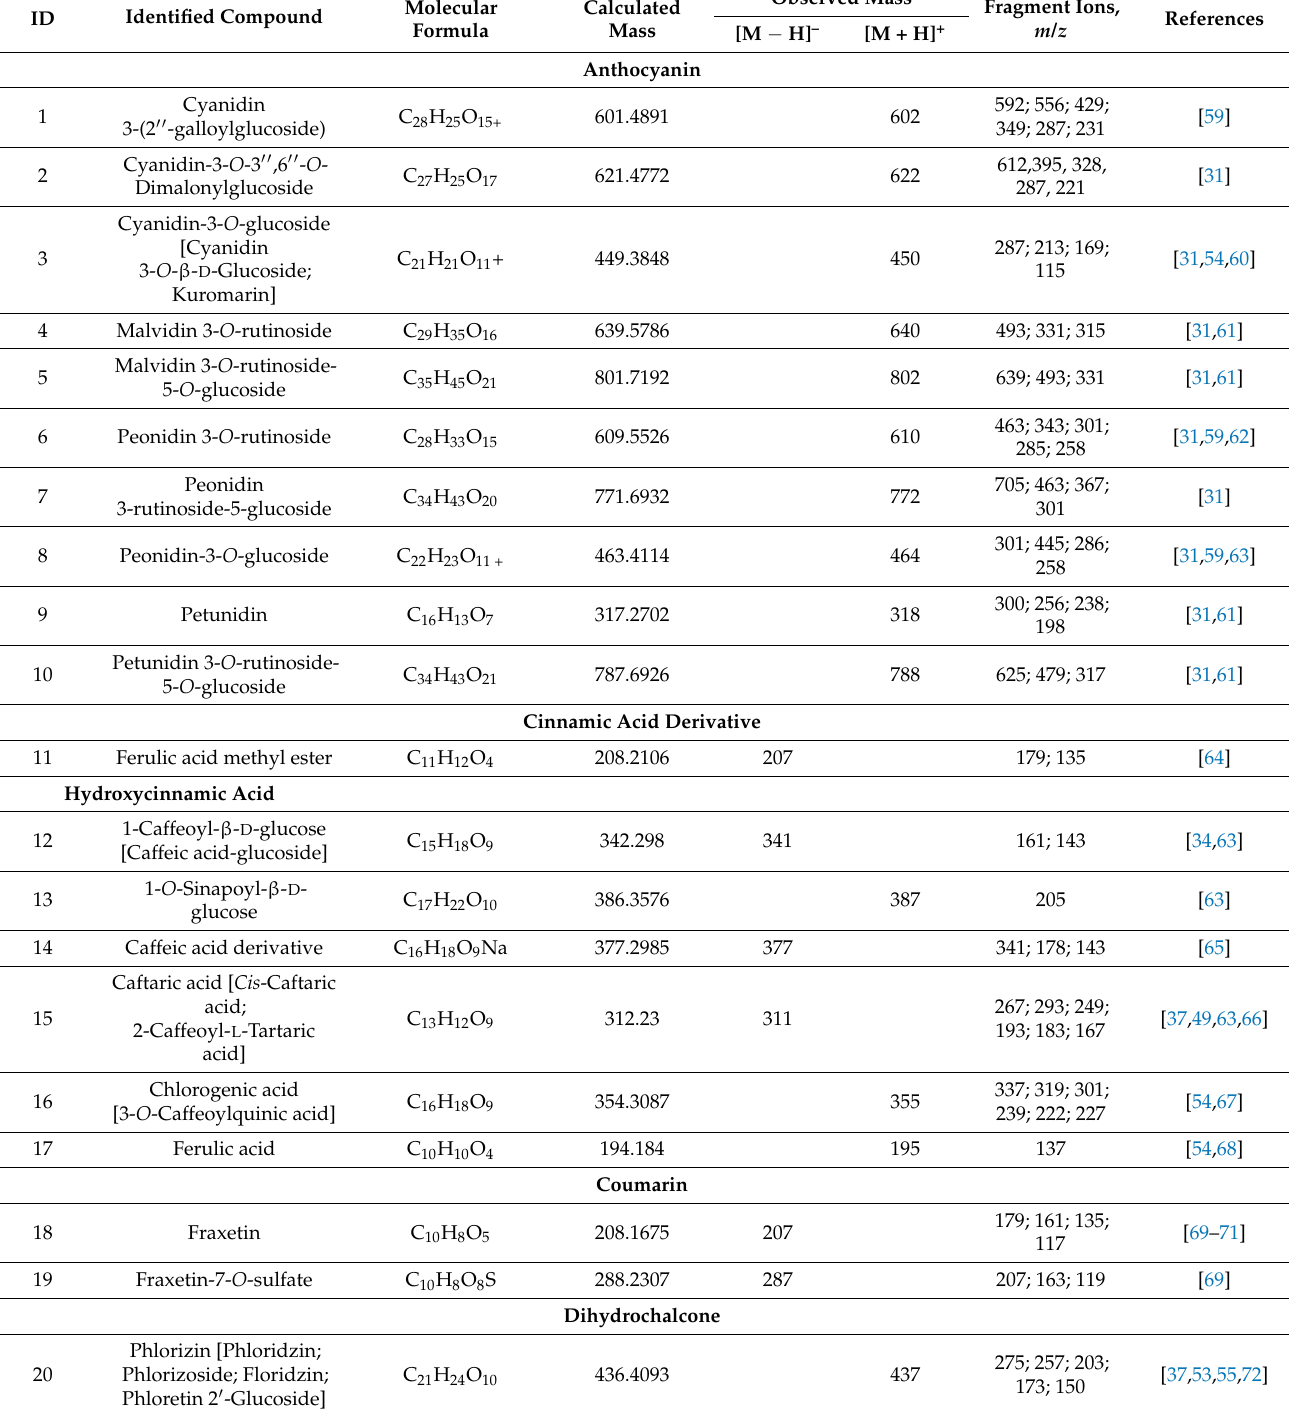
Table A1. The list of compounds identified in EtOH extracts of T. aestivum